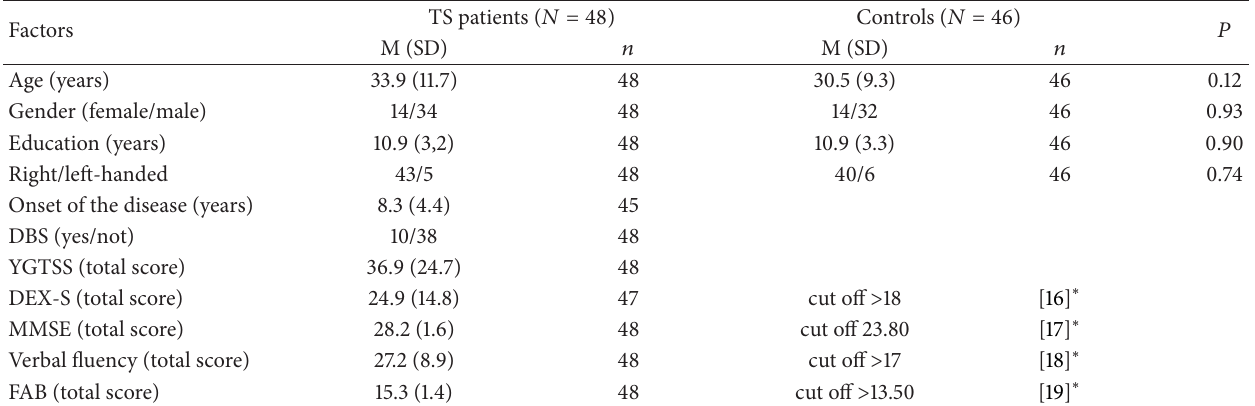
Table 1: Demographic, clinical, and neuropsychological data of TS patients ( 𝑛 = 48 ) and healthy controls ( 𝑛 = 46 ). Data are expressed as mean (SD).